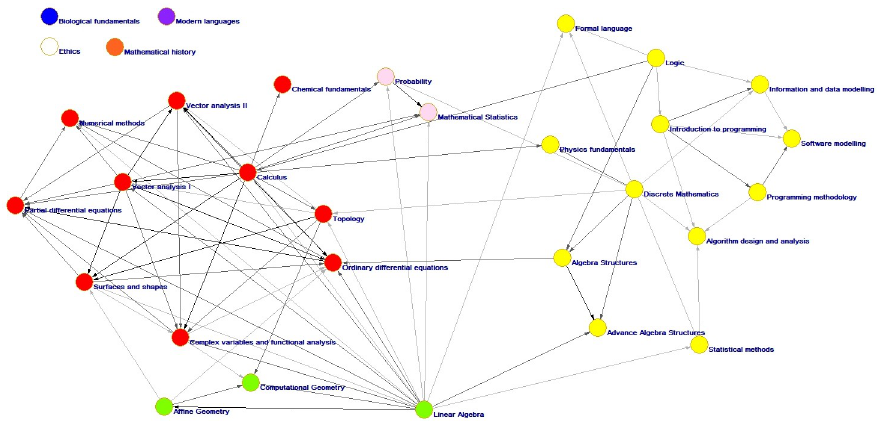
Fig 11. Community network describing the curriculum of the URJC mathematics